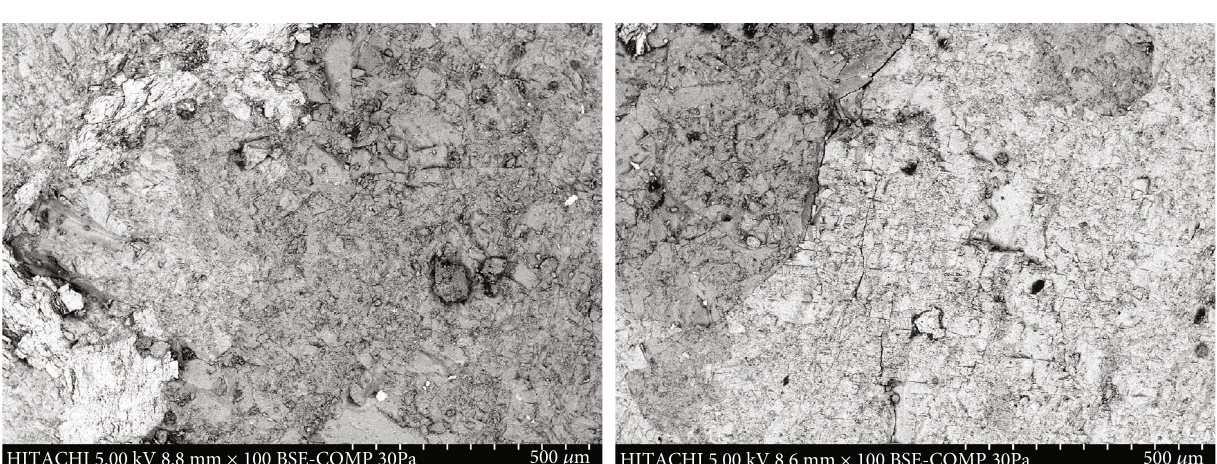
Figure 2: Microstructure of granite before rock burst experiment.